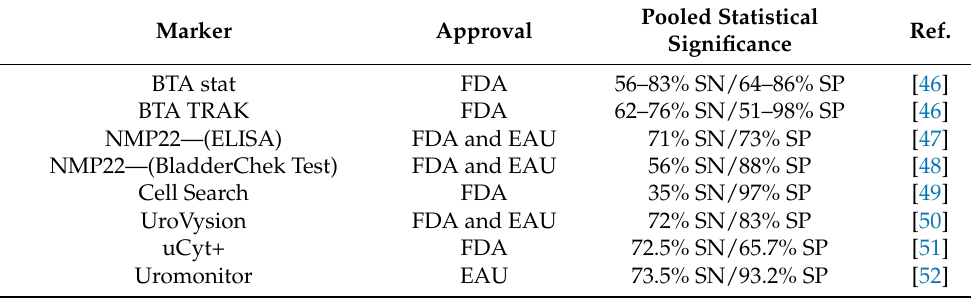
Table 1. Commercially approved markers.